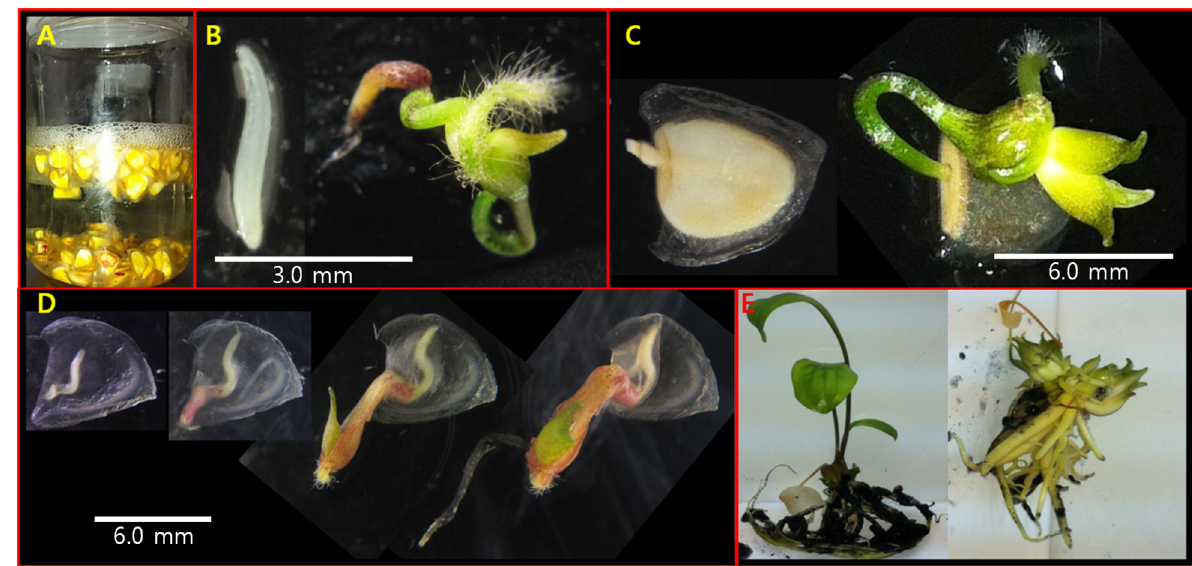
Figure 2. In vitro culture of mature and immature seeds from the cross of L. hansonii × L. brownii var. colchesteri . ( A ). F 1 seed sterilization. ( B ). Immature embryo removed from testa ( left ) and after a 3-month culture of embryos ( right ). Scale bar represents only the size of the immature embryo ( left ). ( C ). Fully developed seed ( left ) and germinated seedling after a 3-month in vitro culture ( right ). ( D ). Four different growth images of an immature seed. ( E ). Morphological variation in F 1 seedlings during in vitro culture.